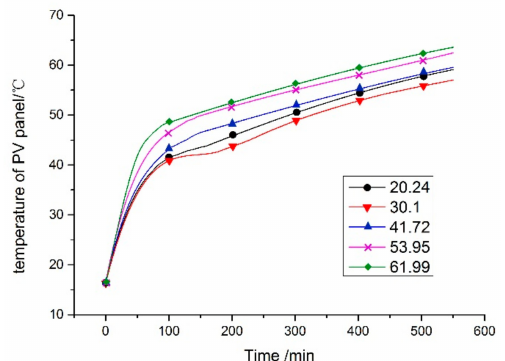
Figure 8. Temperature curve of PV panel with time under di ff erent